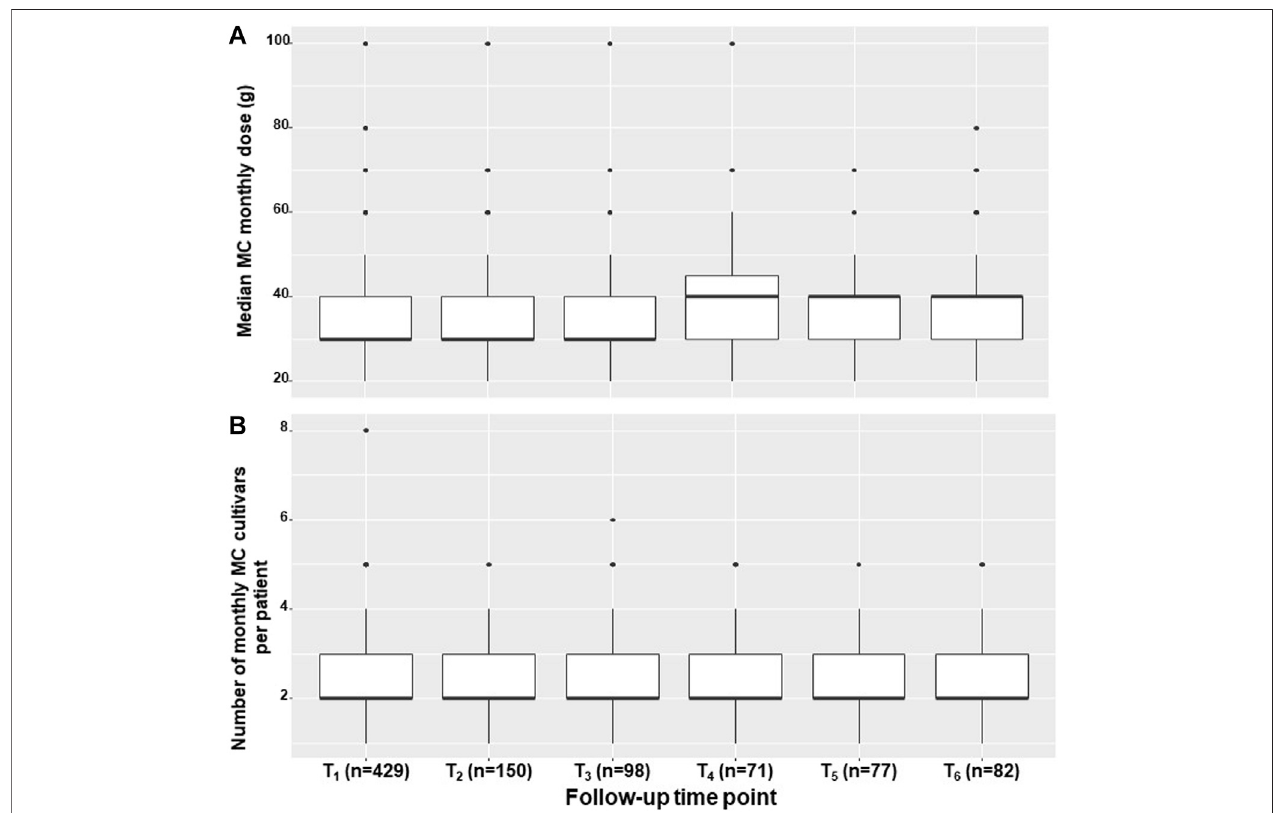
FIGURE 2 | MC treatment measures across study period. The median, inter quartile range, total range and outliers for the monthly medical cannabis dose (A) and number of medical cannabis cultivars that are combined in a month period (B) , displayed for the study sample at one month intervals within a six-month period. MC, Medical cannabis; g, grams; T 1 -T 6 , one to six months follow ups,